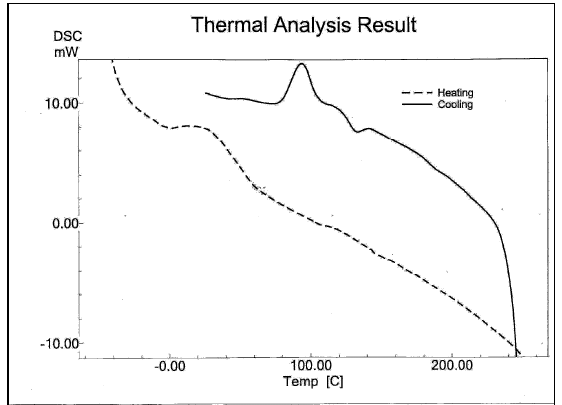
Figure 3. The DSC thermograms of polystyrene material obtained at 20 ºC/min heating and cooling